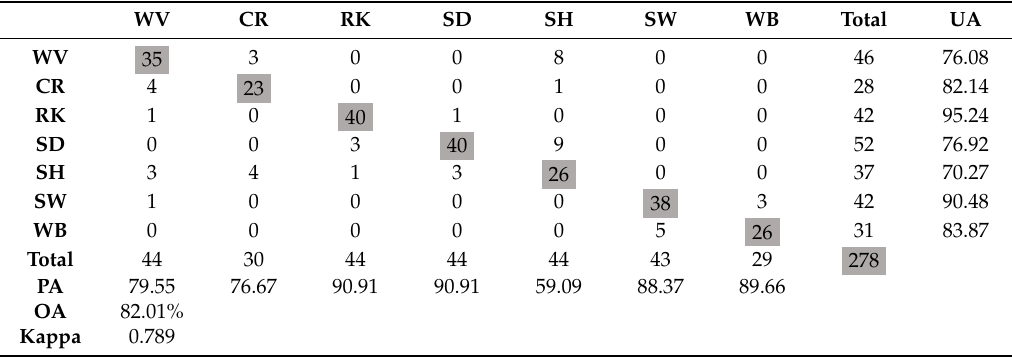
Table 4. Confusion matrix and classification of the accuracies of the seven classes of wooded vegetation (WV), crops (CR), rocks (RK), sand dunes (SD), shrubs (SH), shadow (SW), and water bodies (WB). The accuracies include the overall classification accuracy (OAC), kappa statistic, producer accuracy (PA) and user accuracy (UA).